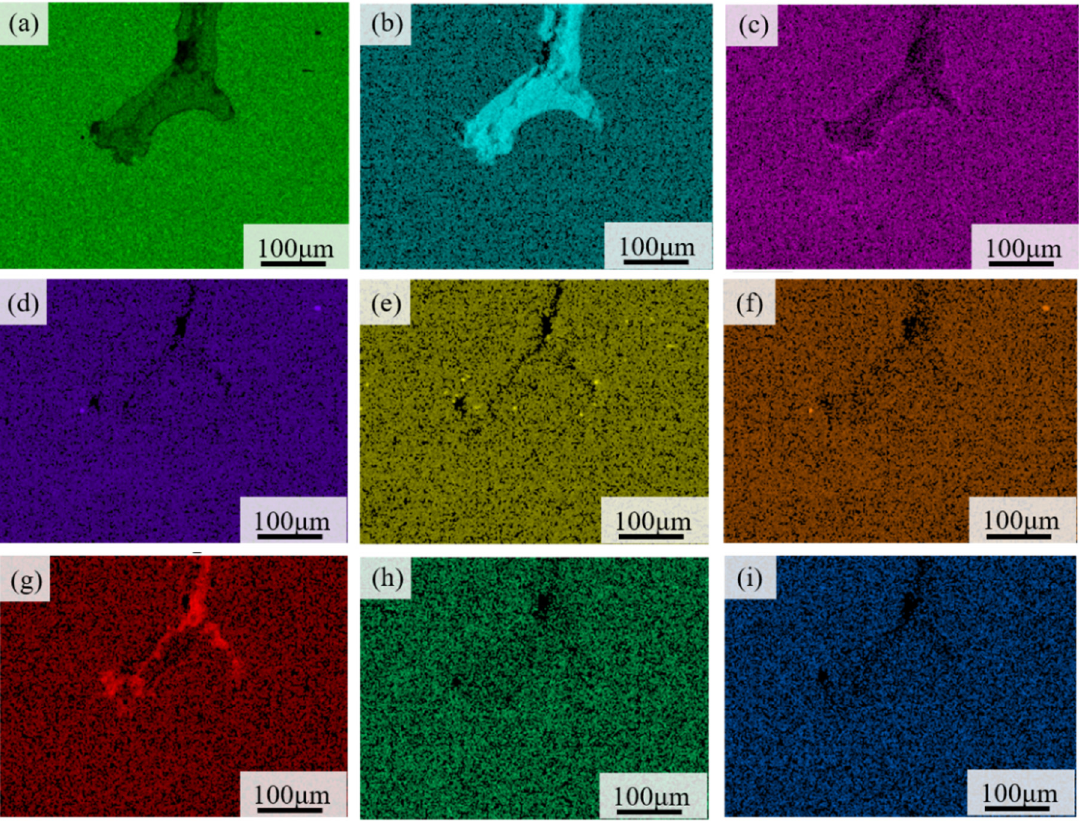
Figure 12. The element distribution map at the crack tip of material ZG2: ( a ) Fe; ( b ) O; ( c ) Cr; ( d ) Mo; ( e ) Si; ( f ) Mn; ( g ) C; ( h ) V; ( i ) Ni.